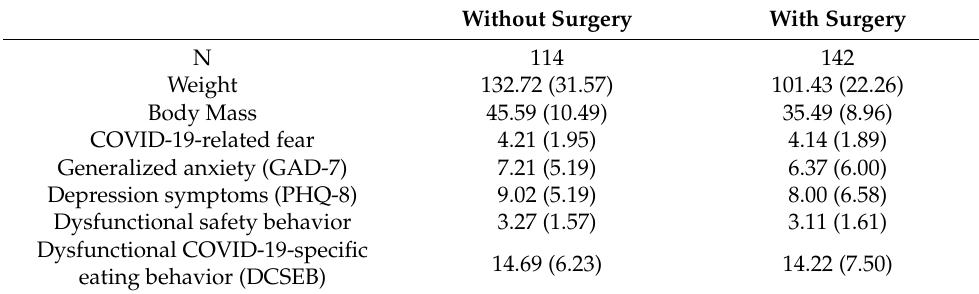
Table 2. Psychometric data for the obesity patients with and without an obesity-specific surgery. Mean sum scores and standard deviations (in parentheses) are listed. Without Surgery With Surgery N 114